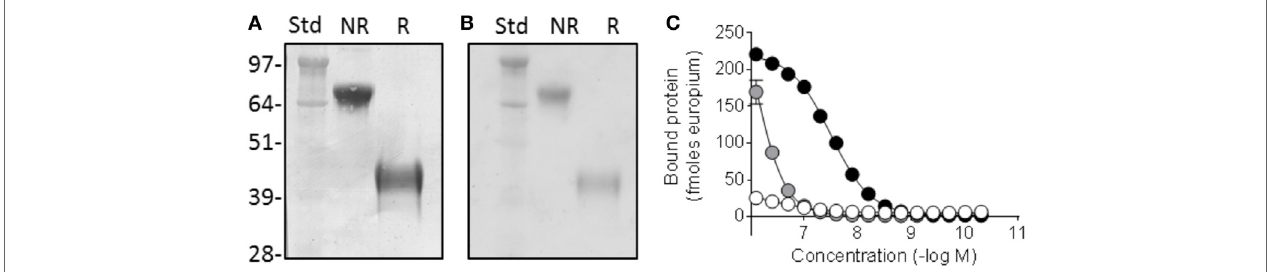
FigUre 1 | Fcp5 is secreted as a glycosylated dimer with heparin-binding activity. (a) Coomassie-stained SDS-PAGE gel showing dimeric construct in the non-reduced (NR) form which is reduced to monomer when reduced (R). (B) Glycosylation of Fcp5 shown by periodic acid Schiff-stained gel. (c) Heparin binding was observed with Fcp5 (black) and peptide p5 (gray) but not Fc2a control